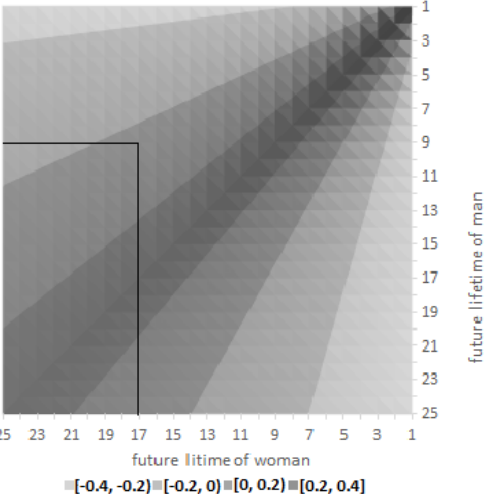
Figure 3. The relative increase in benefits in both variants for spouses aged 75.